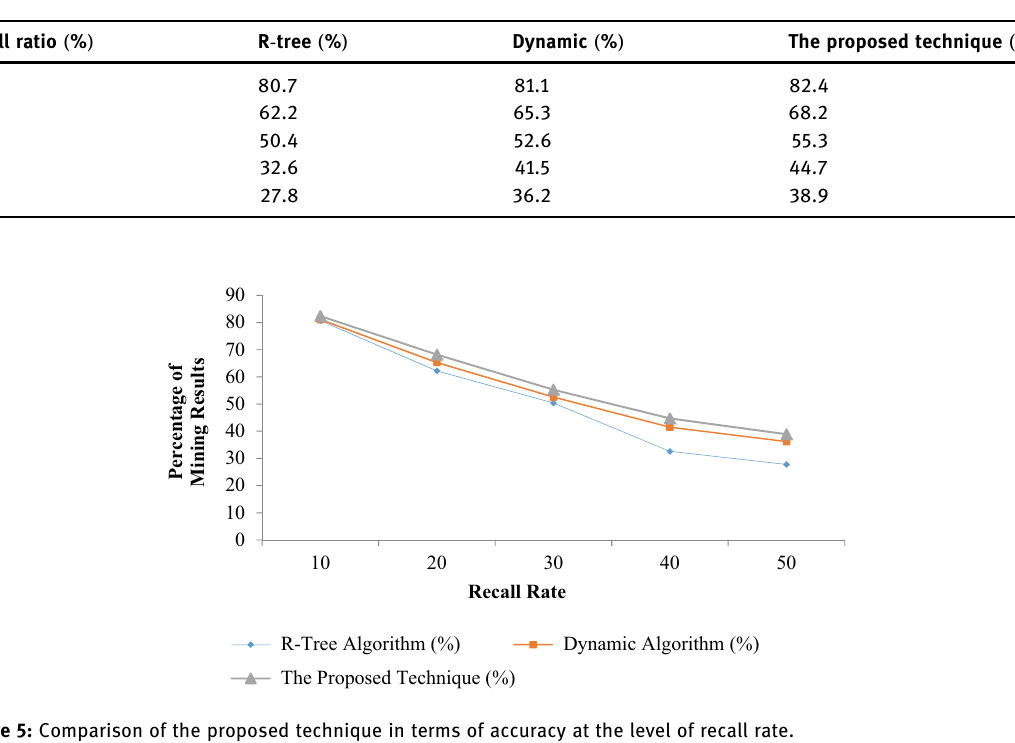
Table 4: The mining time, mining acceleration ratio, and mining speed are obtained Mining time ( s )